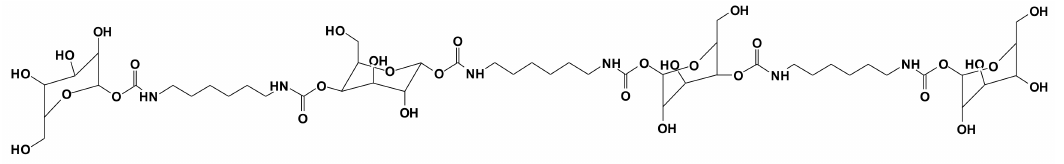
Figure 6. Example of the linear structure, one of the possible structures of the trimer at 1225.6